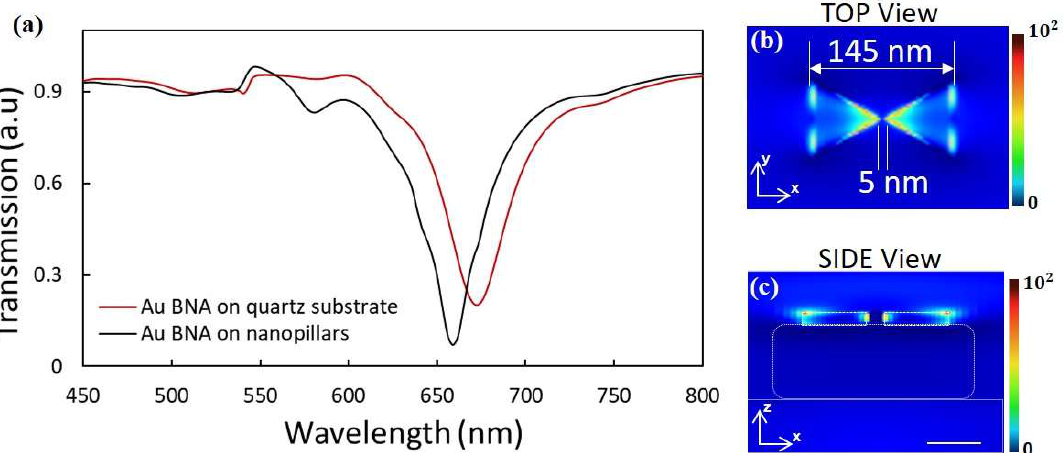
Figure 2. ( a ) The transmission spectra of the plasmonic structures depicted in Figure 1, with P = 550 nm and n = 1. The black curve is for Au bow tie nanoantennas on SiO 2 nanopillars, which are placed on the quartz substrate. The red curve is for Au bow tie nanoantennas directly placed on the quartz substrate. Electric field distribution, abs (E/E 0 ) (in a linear scale), of the structure with Au bow tie nanoantennas on nanopillar, which is placed on the quartz substrate ( b ) top view ( c ) side view. The presence of SiO 2 nanopillars reduces the line width of the plasmonic